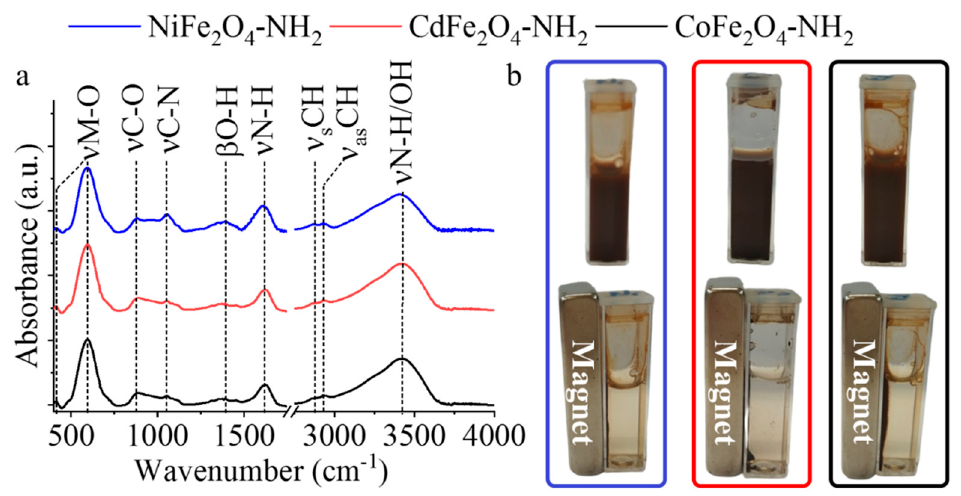
Figure 3. ( a ) FTIR spectra of the NiFe 2 O 4 -NH 2 , CdFe 2 O 4 -NH 2 and CoFe 2 O 4 -NH 2 supports. ( b ) Demonstration of the good dispersibility and separability of the nanoparticles by magnetic field.